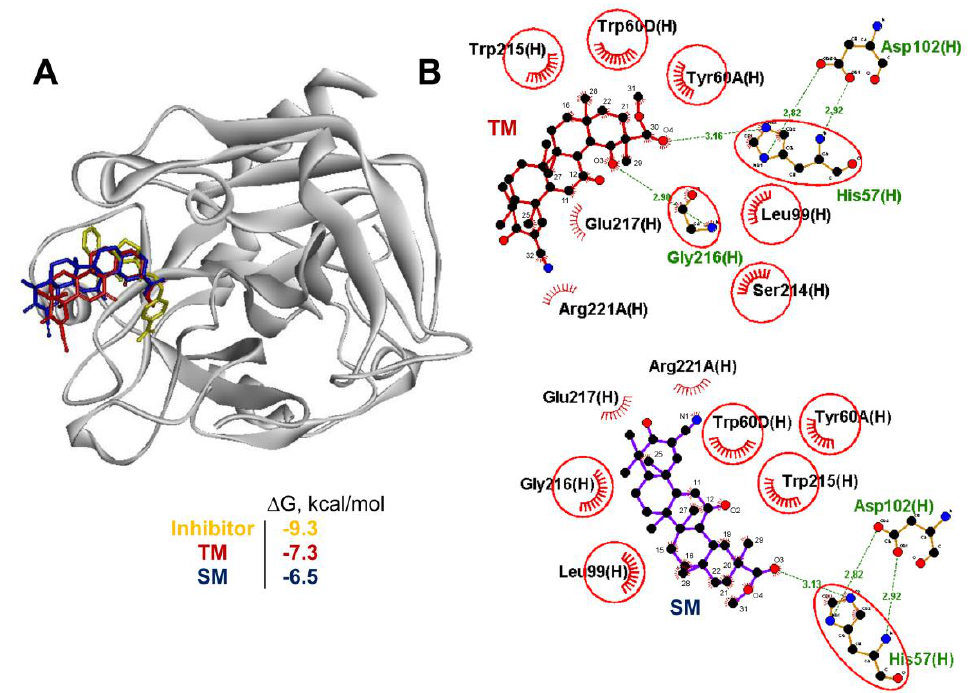
Figure 7. TM can target thrombin. ( A ) A stereo presentation of the docked poses of TM and SM in thrombin superimposed on the thrombin inhibitor-bound structure. ( B ) A 2D representation of the docked poses of TM and SM in thrombin. Common residues, interacting with both the inhibitor and TM, are highlighted in red circles. The comb and green dashed lines represent nonbonding contacts and hydrogen bonds, respectively.